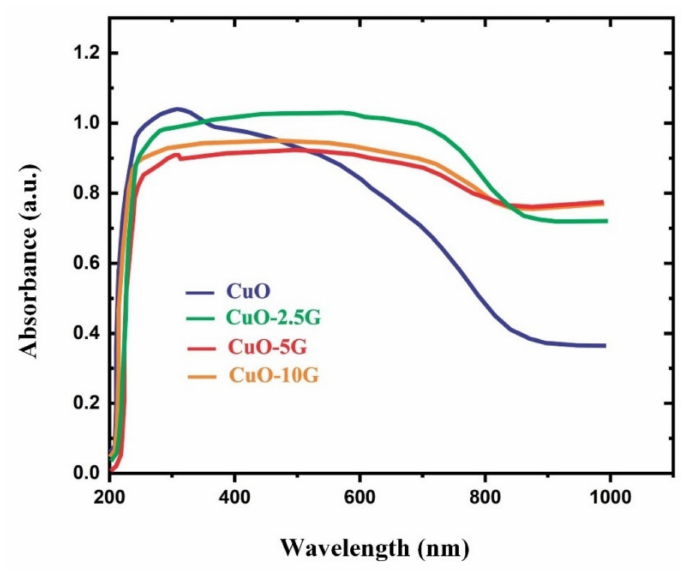
Figure 6. UV-Vis absorption spectra of the samples.